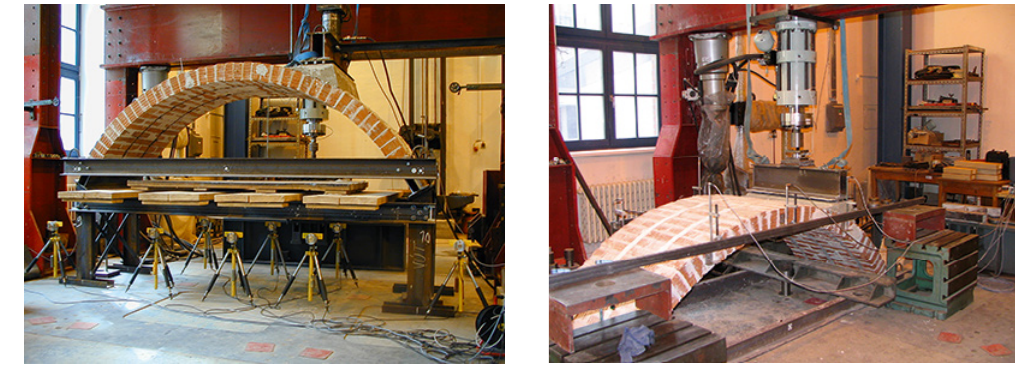
Figure 3. Strengthened vault loaded asymmetrically at the quarter